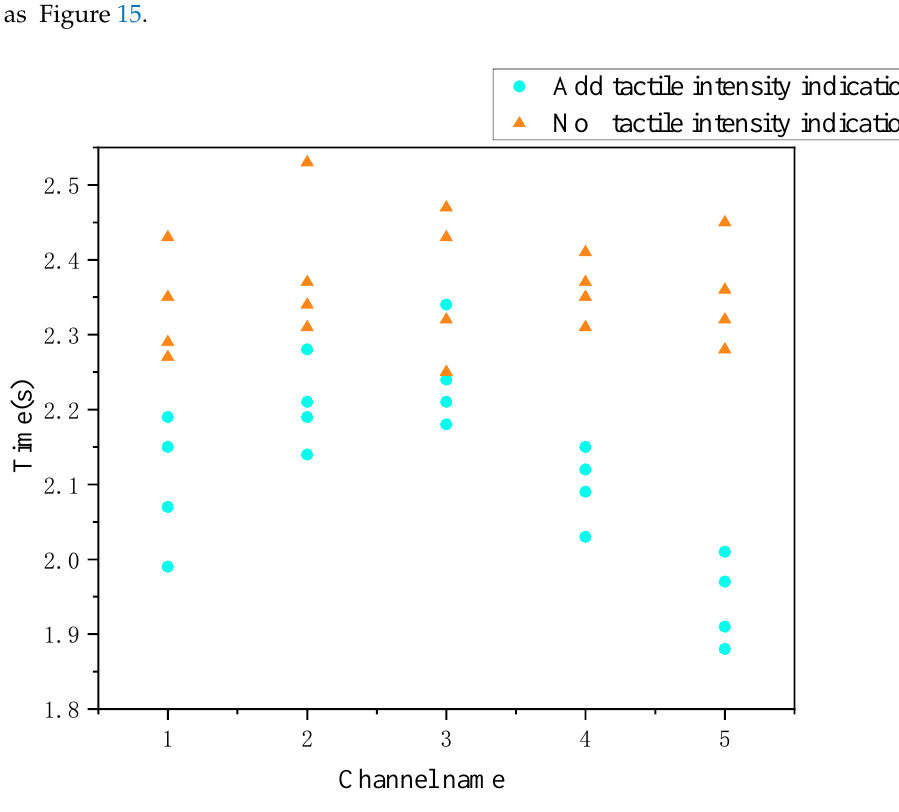
Figure 15. Time comparison with and without tactile intensity stimulation.